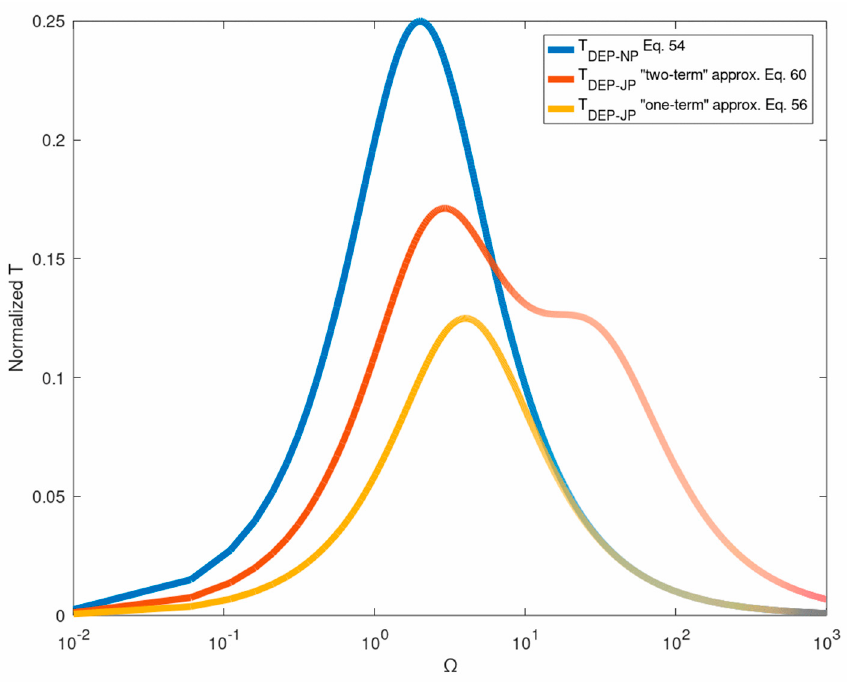
Figure 6. Comparison between the ‘two-term’ (Equation (60)) approximate ROT spectra for the JP torque against the corresponding spectrum for a NP (Equation (54)). Also shown is the ‘one-term’ JP approximation.